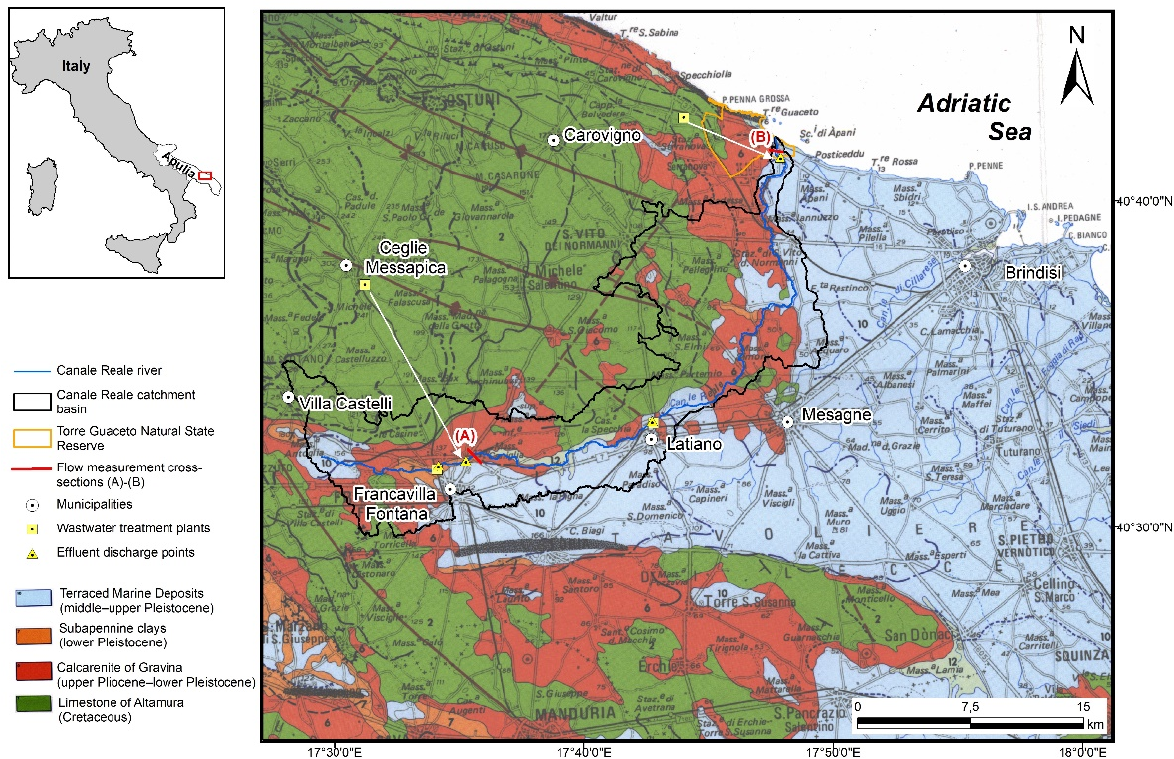
Figure 3. Study area and geological map (modified after Ciaranfi et al., 1988 [37]).